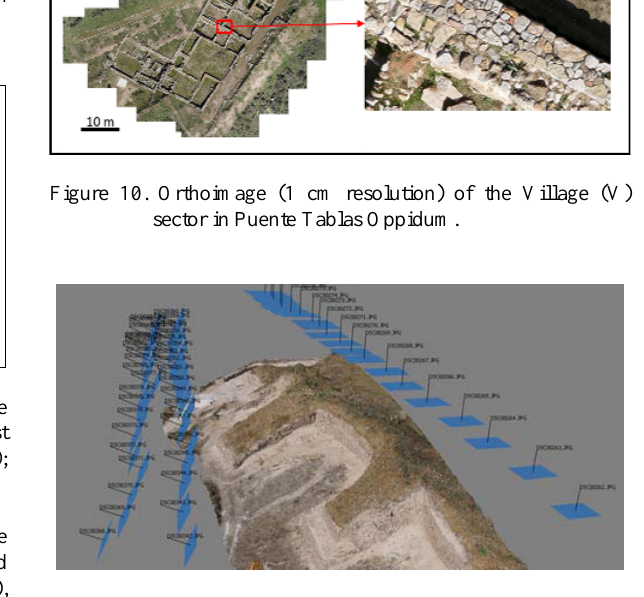
Figure 11. Flight strips above the walls and bastions.